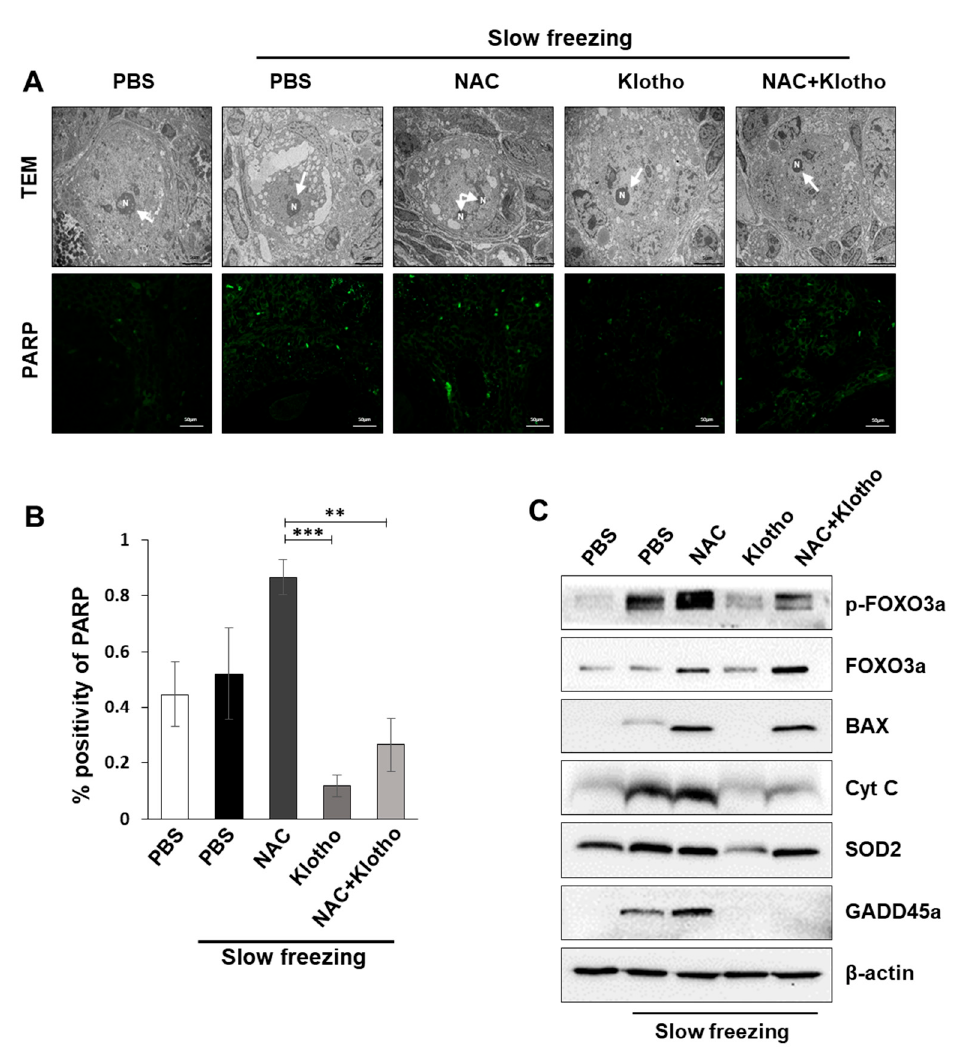
Figure 4. Klotho protein reduces cell death produced by oxidative stress caused by cryopreserva- tion. ( A ) Representative image showing the fragmented nuclear structure observed with a TEM (5000× magnification; top) and IF images of PARP in the indicated conditions (400× magnification; bottom). ( B ) Percentage of PARP-positive cells analyzed by ImageJ. ( C ) Expression of apoptosis-related proteins, including pro-apoptotic protein Bax and anti-apoptotic protein Bcl-2, was detected by immunoblotting. All data are shown as mean ± SD. The p values were determined by one-way ANOVA. ** p < 0.01; *** p < 0.001. n = 6 each group. Each experiment was repeated three times.